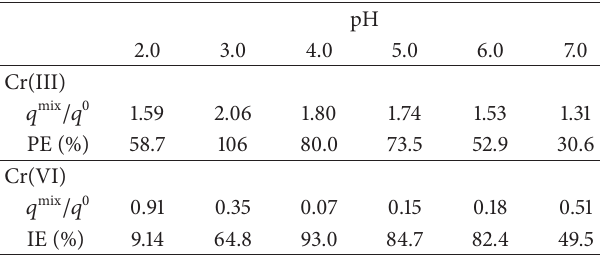
Table 4: Effects of Cu(II) on Cr(III) and Cr(VI) adsorption onto kaolin under different pH